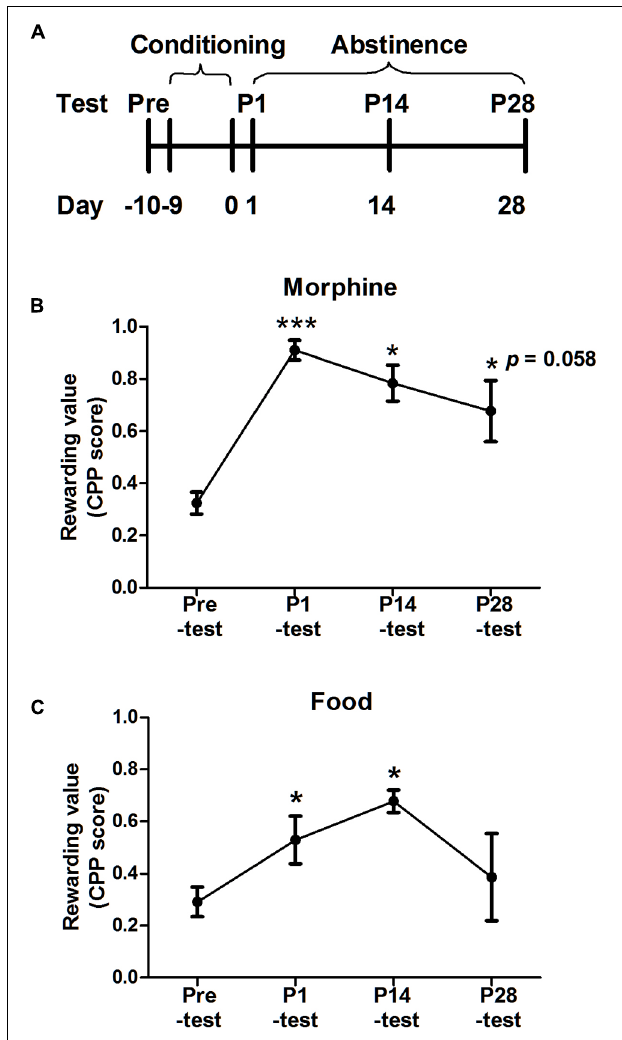
FIGURE 3 | Place preference induced by morphine or food during abstinence. (A) Diagram outlining the behavioral procedures. After conditioning and P1-test, both groups were tested for CPP every 2 weeks during abstinence. (B) Morphine conditioned group maintained preference for 28 days. (C) Food conditioned group maintained for 14 days. Data were expressed as the means ± SEM, n = 4. ∗ p < 0.05, ∗∗∗ p < 0.001, compared with their